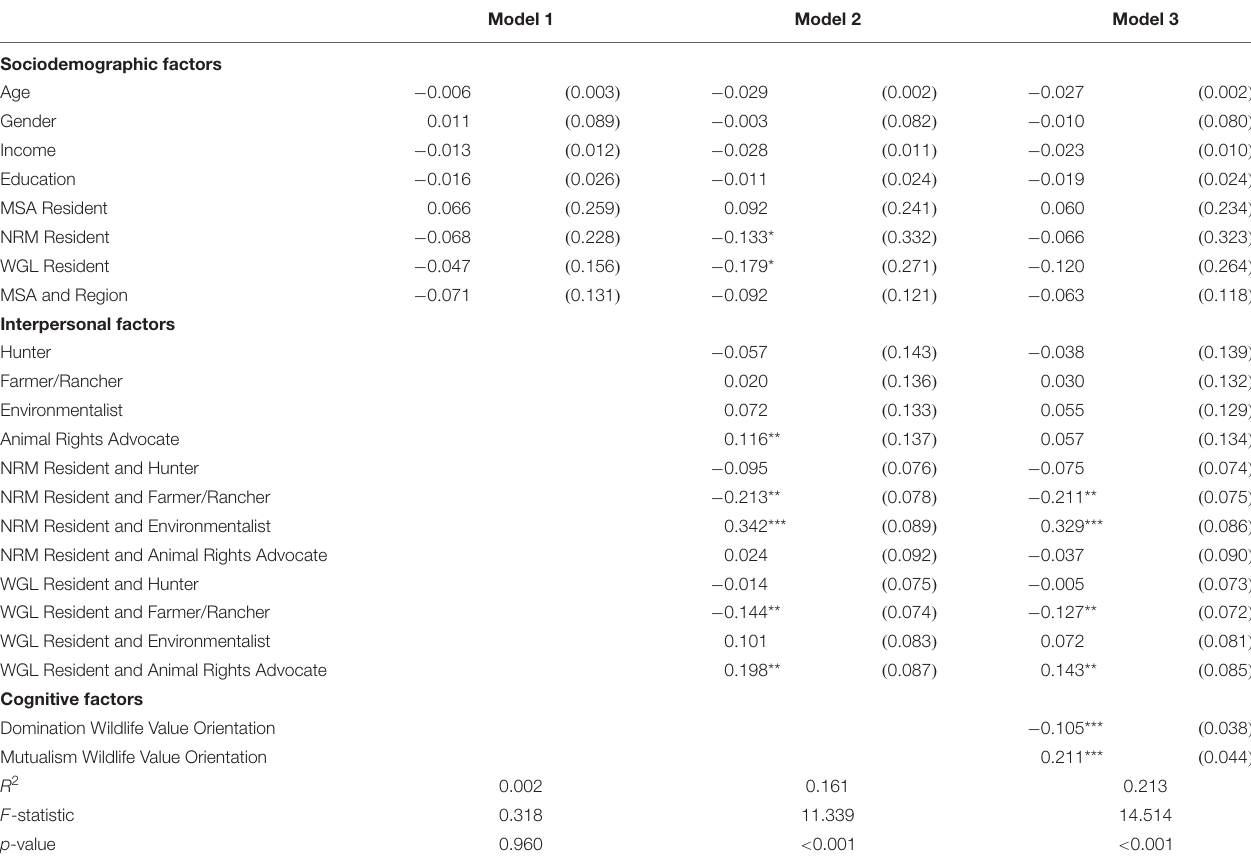
TABLE 2 | Standardized coefficients for hierarchical regression analyses predicting attitudes toward wolves in the United States